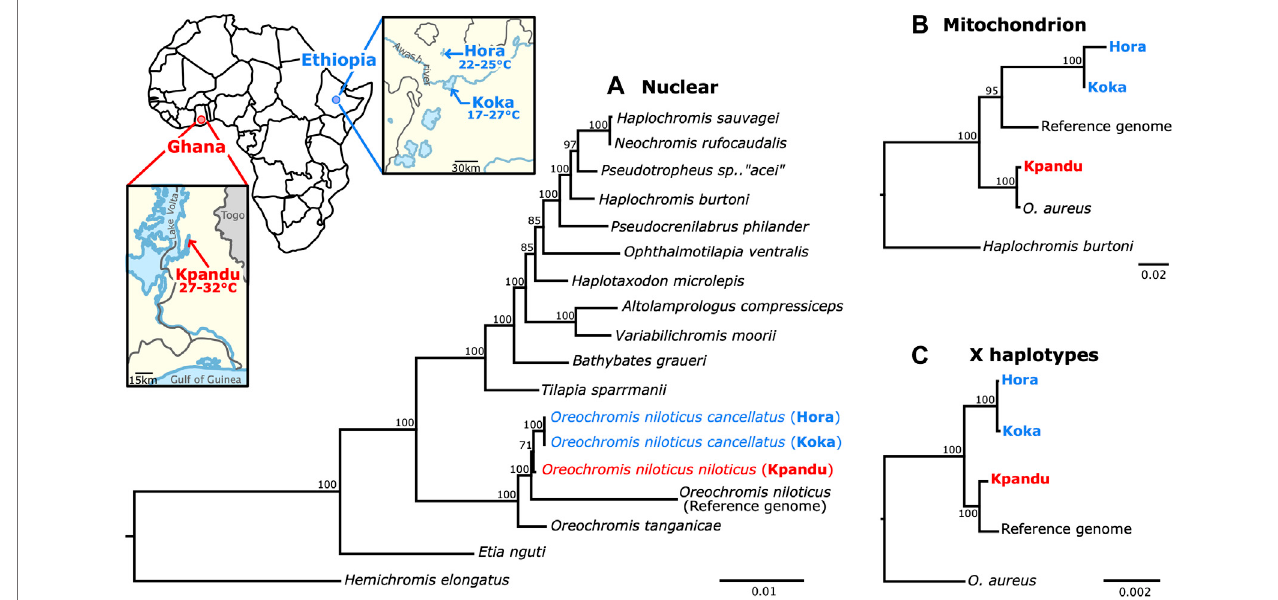
FIGURE 5 | Phylogenetic analysis of Nile tilapia populations and related cichlids built with the maximum likelihood method. Each node of the tree corresponds to bootstrap values. Koka and Hora (in blue) are Ethiopian populations of O. niloticus cancellatus and Kpandu (in red) is a Lake Volta population of O. niloticus niloticus originating from Ghana. (A) Nuclear DNA phylogeny built using the 42 loci from Meyer et al. (2015). The Oreochromis species are forming a monophyletic clade in which the three wild populations are more closely related to each other than to the individual used from the reference genome (Manzala-Stirling strain). The tree is rooted with Hemichromis elongatus . The species from Meyer et al., 2015 are positioned identically to their phylogeny. These results are also showing that the O. niloticus cancellatus Koka and Hora populations are more closely related to each other than to the O. niltocus niloticus of Kpandu population. (B) Mitochondrial DNA phylogeny built from 13 mitochondrial protein-coding genes and the two ribosomal subunits. The tree is rooted with Haplochromis burtoni . This phylogeny is con fi rming that Koka and Hora populations are morecloselyrelatedtoeach other than toKpandu population. O. niloticus samplesfrom Kpandu population are forming amonophyletic clade with O.aureus . (C) LG23XhaplotypephylogenyfromLG23 oaz1 to dot1l genes.Thetreeisrootedwith O.aureus. KokaandHora O.niloticus populationsareforminga monophyletic